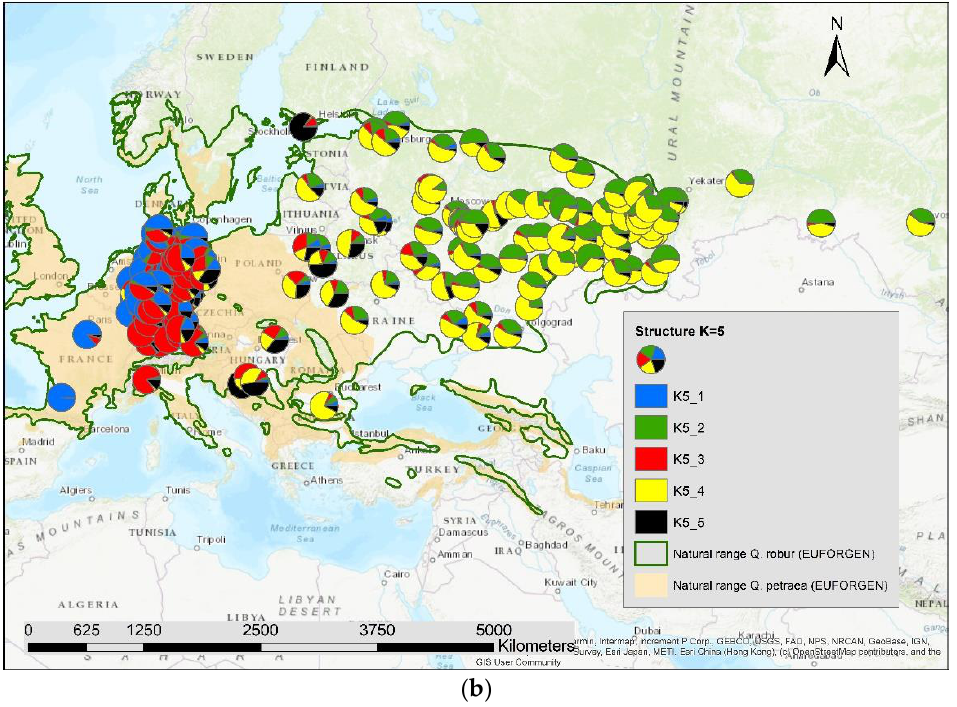
Figure 6. Spatial distribution of the results of STRUCTURE for ( a ) K = 4 and ( b ) K = 5.